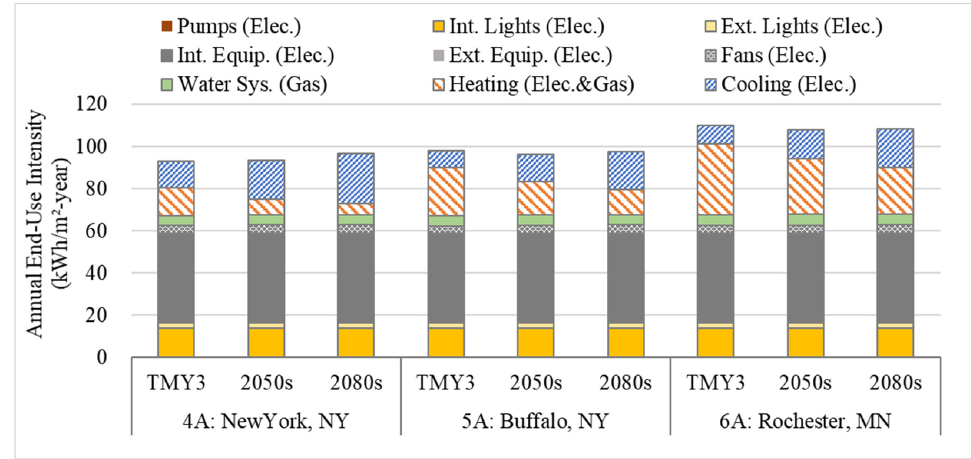
Figure 10. Annual whole building Energy Use Intensity (EUI) of baseline models.